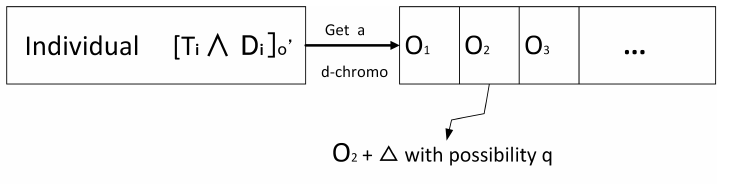
Figure 3. Mutation